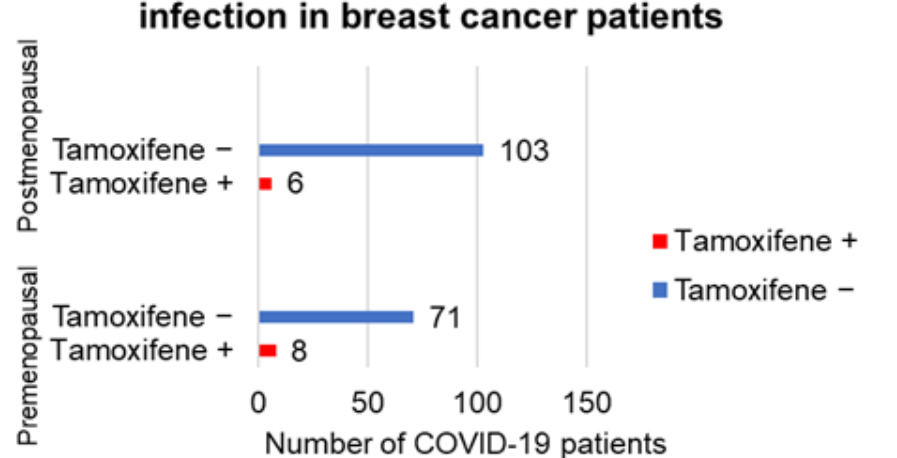
Figure 3. Effect of hormonal therapy of female breast cancer patients with tamoxifene on the sensi- tivity to SARS − CoV − 2 infection. Females treated by this drug were not as sensitive to infection as non-treated patients. The effect of therapy was higher in postmenopausal women without the pro- duction of estrogens.